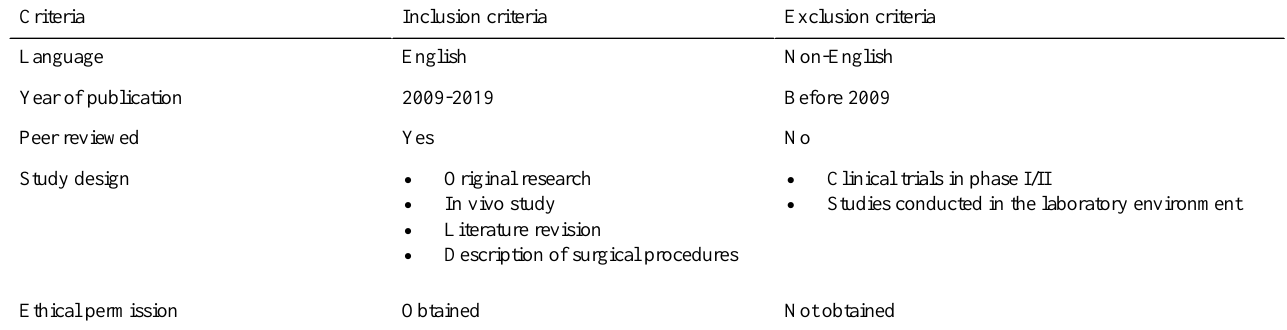
Table 1. Inclusion and exclusion